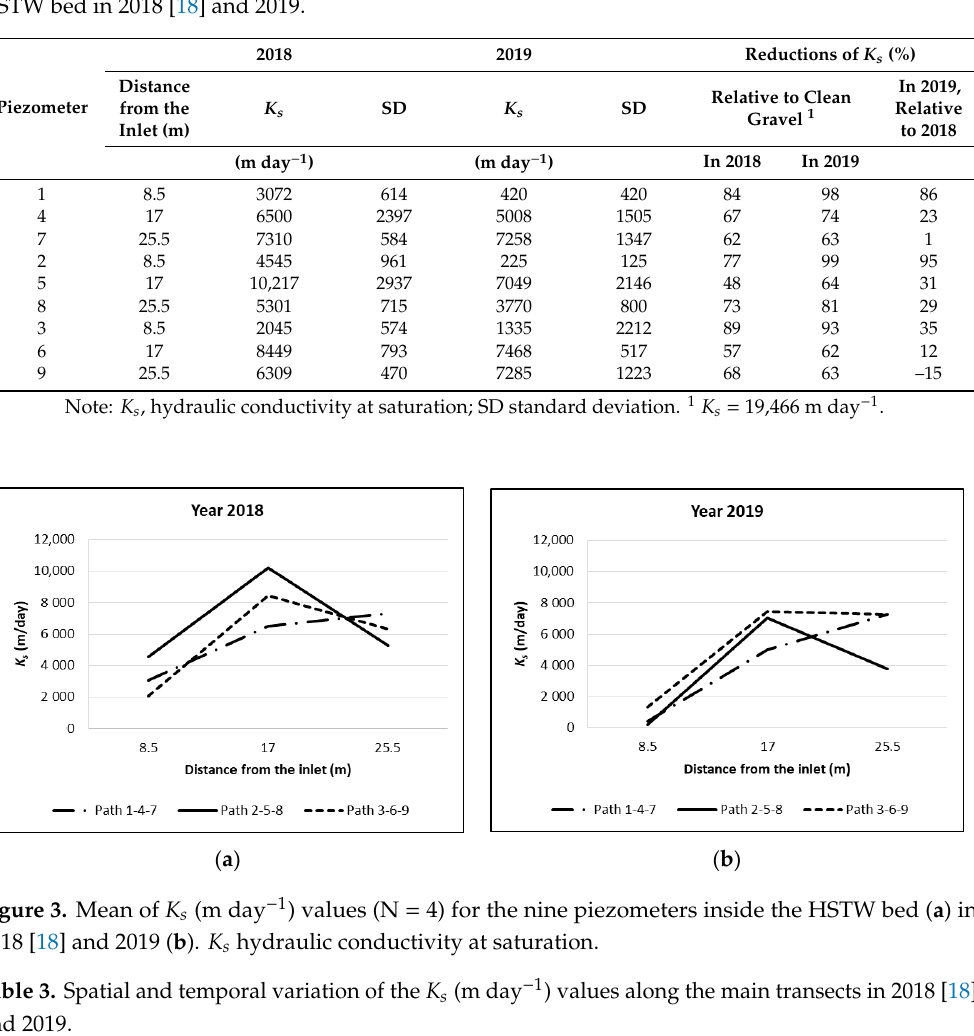
Table 2. Spatial and temporal variation of the K s (m day − 1 ) values for the nine piezometers inside the HSTW bed in 2018 [18] and 2019.